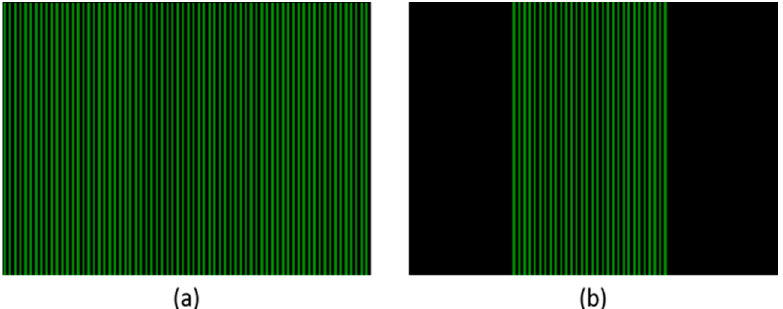
Figure 9. The e ff ective planarization length test pattern. ( a ) original layout pattern, ( b ) the layout pattern that outer vertical gates are removed.